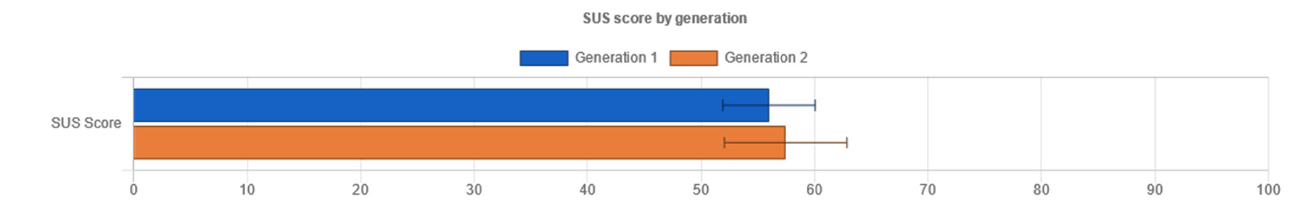
Figure 14. SUS score by generation.